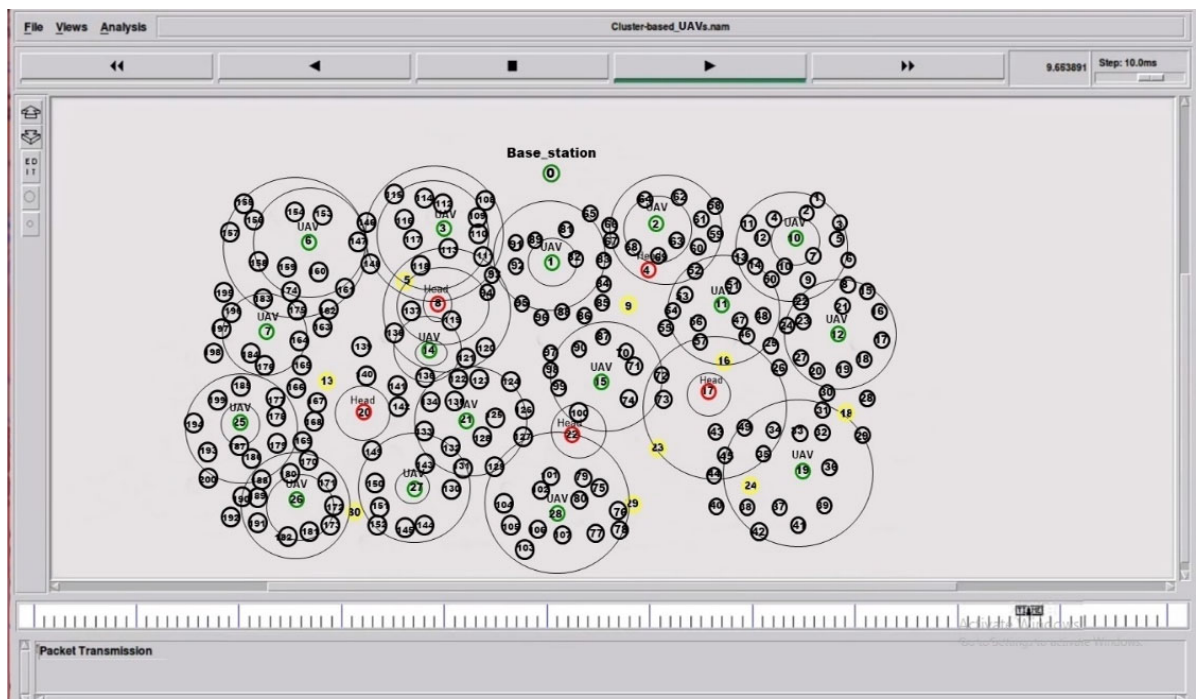
Figure 8. Final result without obstacles.